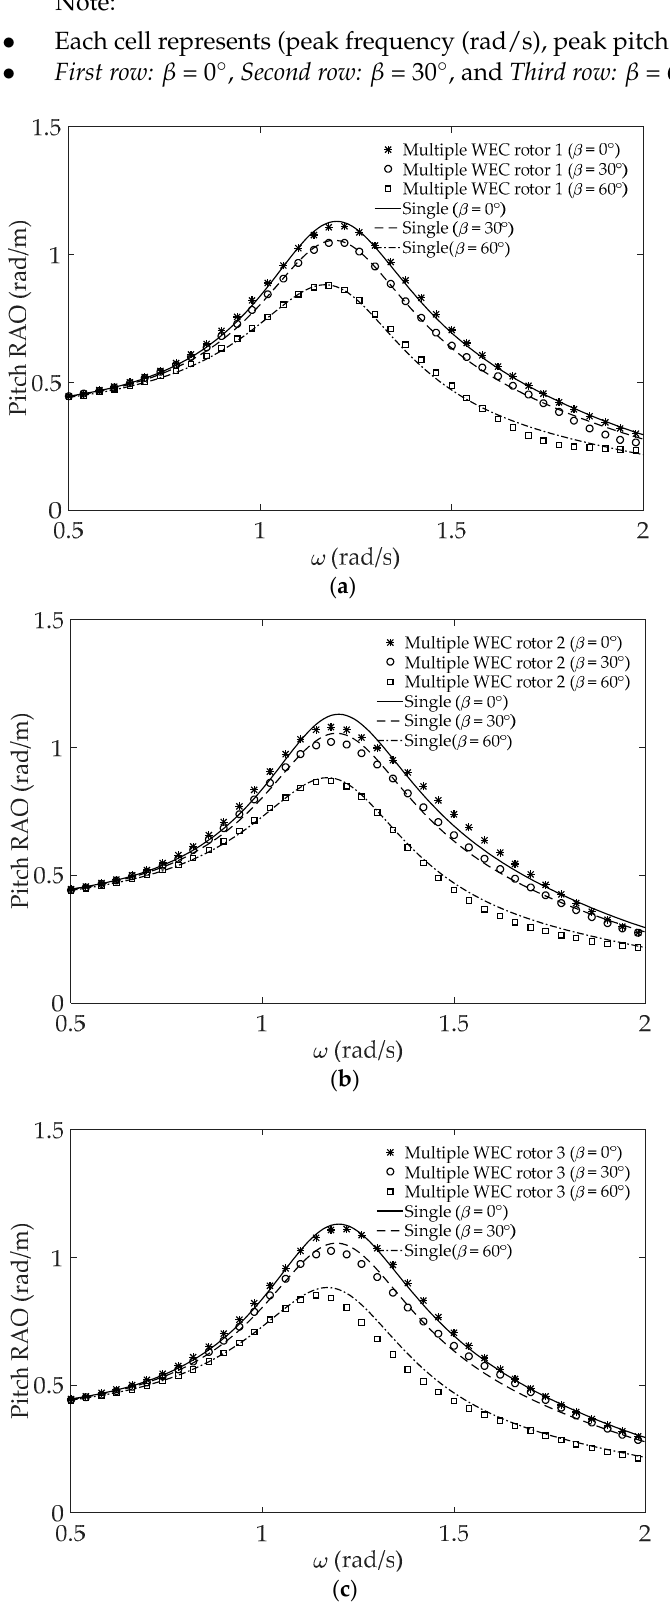
Figure 8. Pitch RAO (rad/m) of isolated and multiple WEC rotors with PTO as a function of the wave frequency (rad/s). Comparison of the isolated WEC rotor and multiple WEC rotors ( a ) 1, ( b ) 2, and ( c ) 3. Table 2. Peak pitch RAO (rad/m) of isolated and multiple WEC rotors with and without the PTO damping for different wave-heading angles (°).